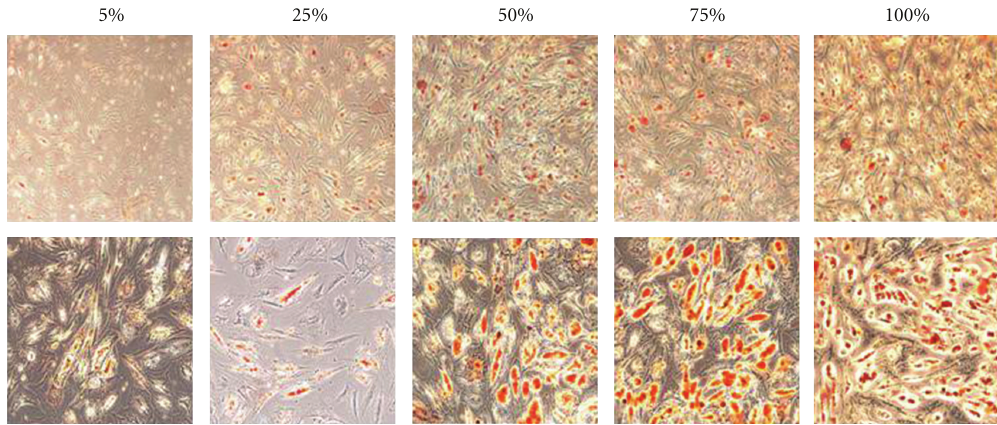
Figure 1: Oil Red-O staining for in vitro adipogenic di ff erentiation of the mixed populations of ASCs and mature fibroblasts. Percentages indicate the proportion of ASCs. Pictures taken with 10X of magnification are showed in the upper line and pictures taken with 20X of magnification are showed in the lower